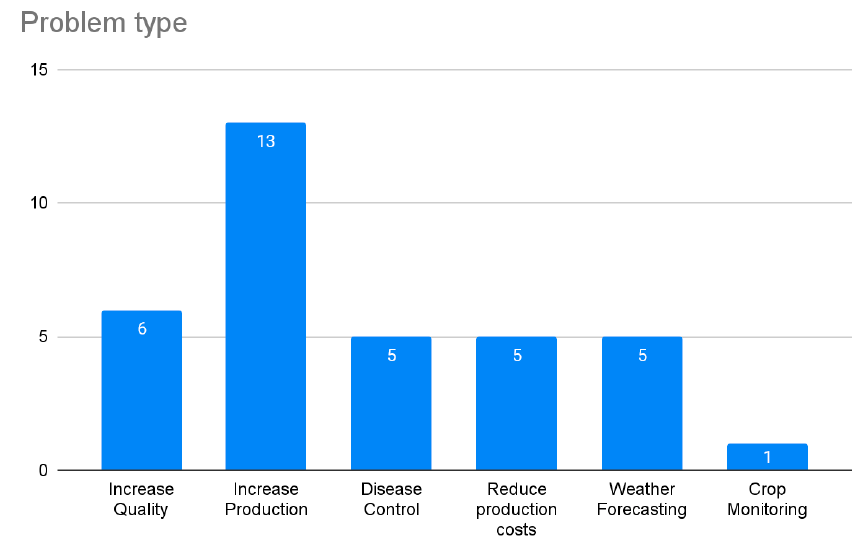
Figure 10. Problems to be solved through agricultural Big Data and ML.